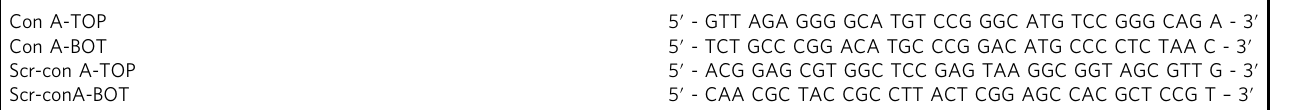
Table 7 Oligonucleotides. Con